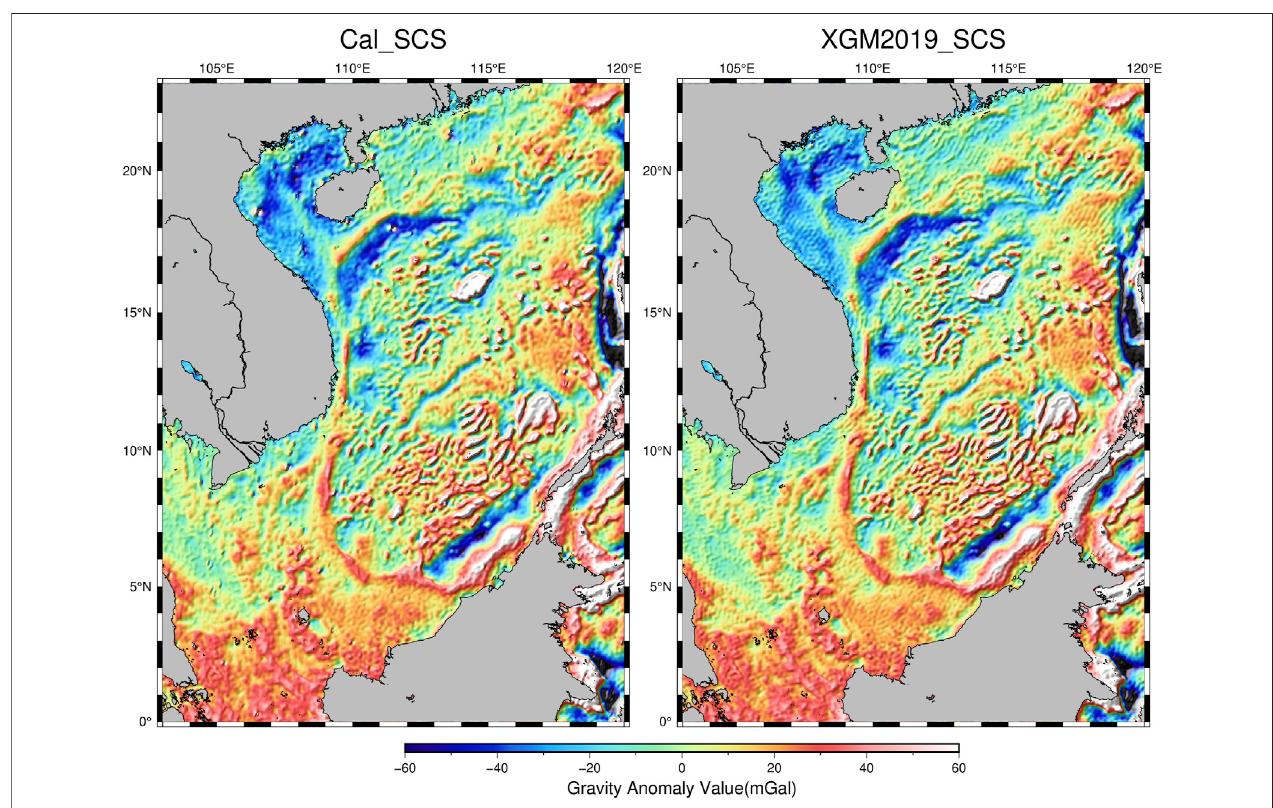
FIGURE 4 | IS-2-derived gravity anomaly over the SCS with remove – compute – restore technique (left) and the corresponding XGM2019 model result (right) .